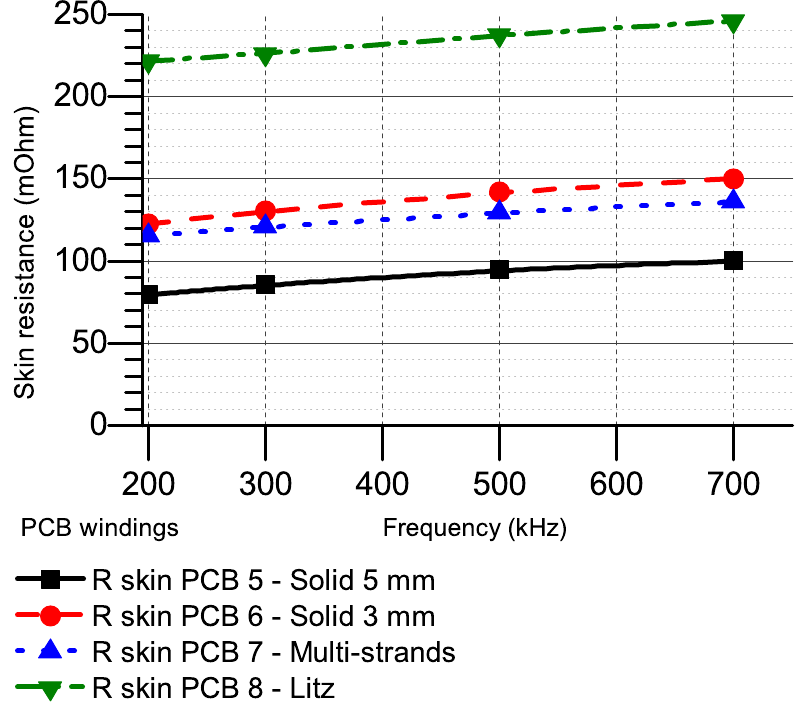
Figure 18. Calculated skin resistances of 7-turn